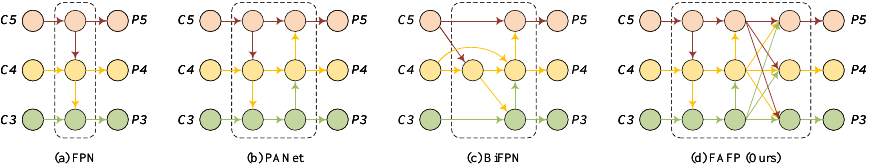
Figure 4. Description of feature pyramid structures. FPN and PANet adopt channel concatenation fusion method. BiFPN and FAFP use the weighted addition fusion method.